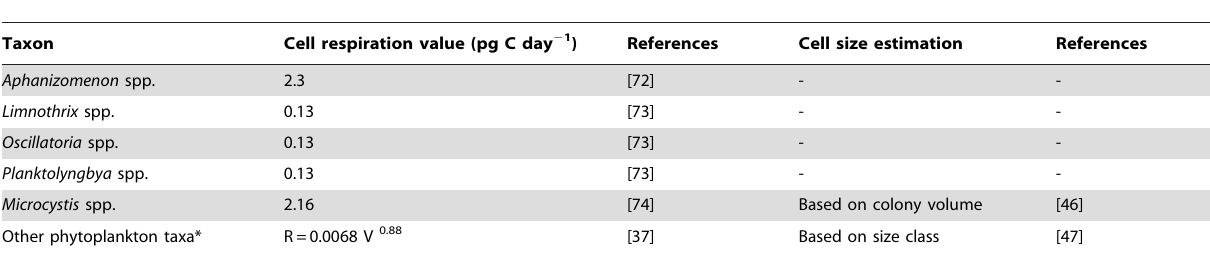
Table 1. Methods used for assessing phytoplankton respiration and cell